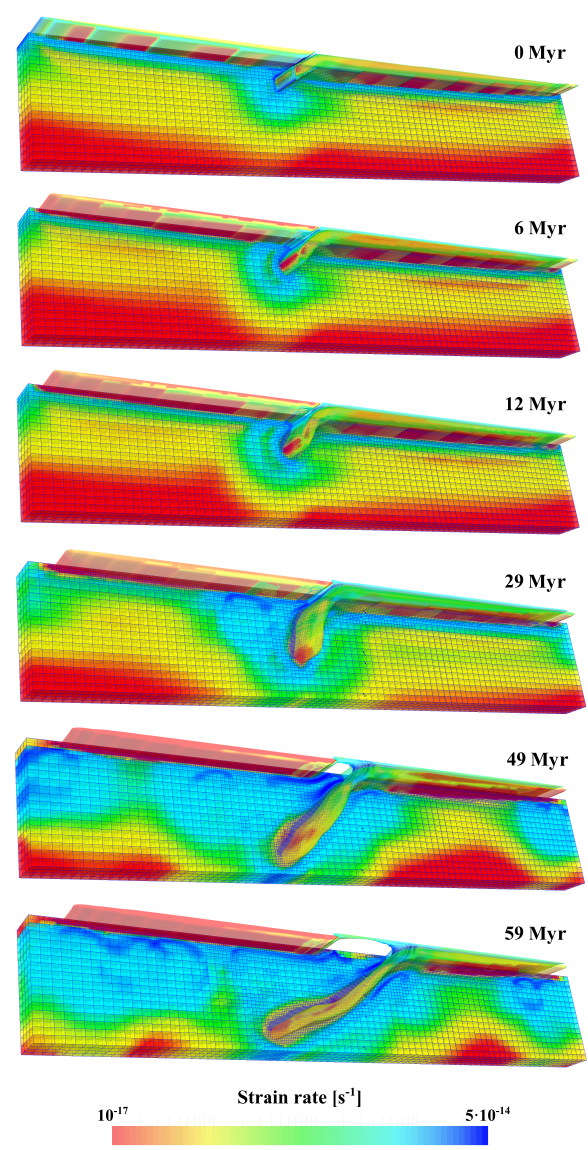
√ ˙ (cid:15) : ˙ (cid:15) over time